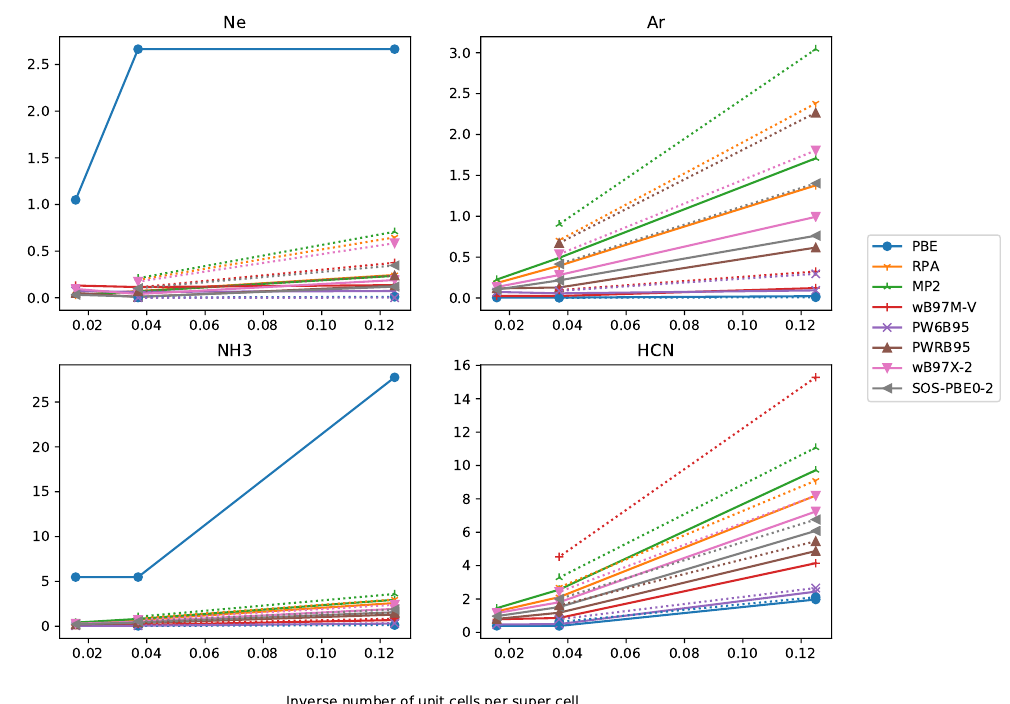
Figure 1. Total energies per formula unit relative to extrapolated total energy in kJ · mol − 1 against inverse number of unit cells in supercell with basis sets of DZ and TZ quality for the systems Ne, Ar, NH 3 ,